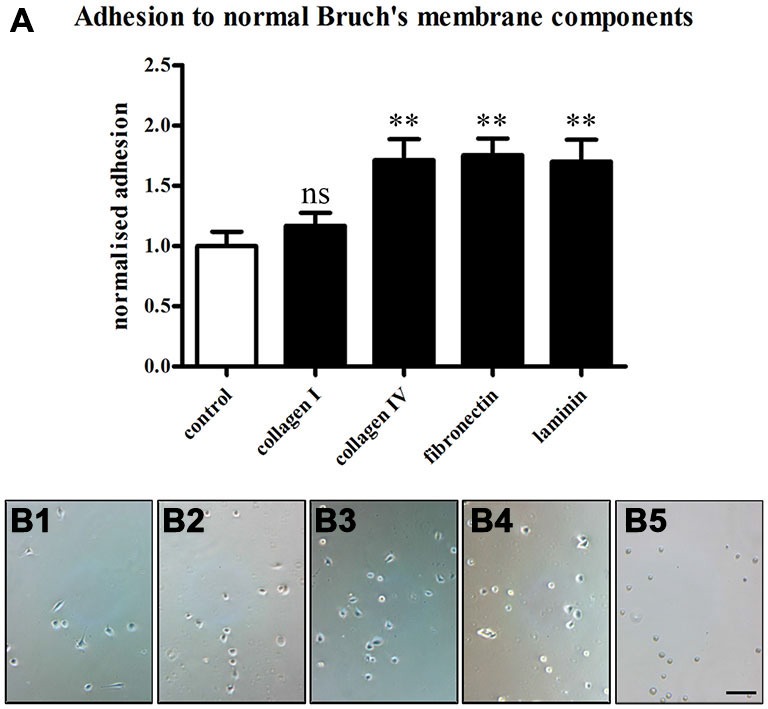
Adhesion of RPE cells to normal Bruch’s membrane components. RPE cells (28,000 cells/cm2) were seeded on the normal Bruch’s membrane components collagen I, collagen IV, fibronectin and laminin (1 μg/ml), and 1 h adhesion assays were carried out. Afterwards, the coverslips were washed three times with PBS to remove unbound cells, and attached cells were counted under phase contrast. (A) The Bruch’s membrane components promoted the adhesion of the RPE cells in the order of fibronectin > collagen IV > laminin > collagen I > non-coated. The number of RPE cells binding to collagen IV, fibronectin and laminin was significantly increased compared to control (ANOVA: ** = P < 0.01, ns = non-significant). (B) Adhesion assay on control non-coated glass coverslips (B1) and in collagen I- (B2), collagen IV- (B3), fibronectin- (B4) or laminin-coated (B5) conditions. n = 3. Scale bar = 200 μm.